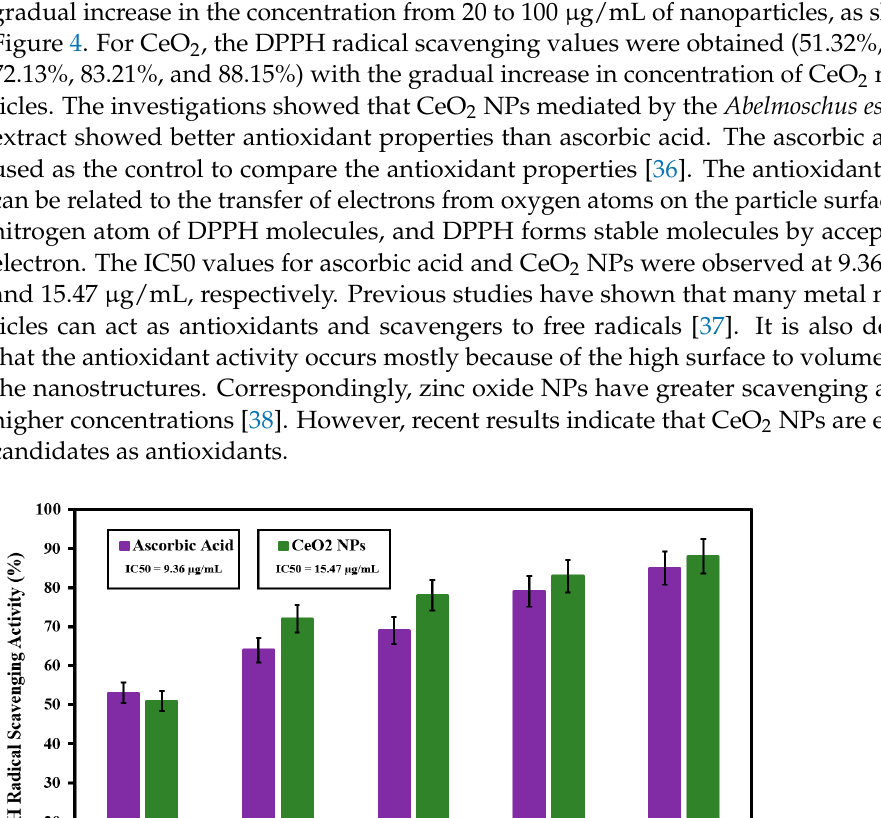
Figure 3. Green synthesized CeO 2 nanoparticles ( a ) UV-visible and ( b ) FTIR spectroscopy.